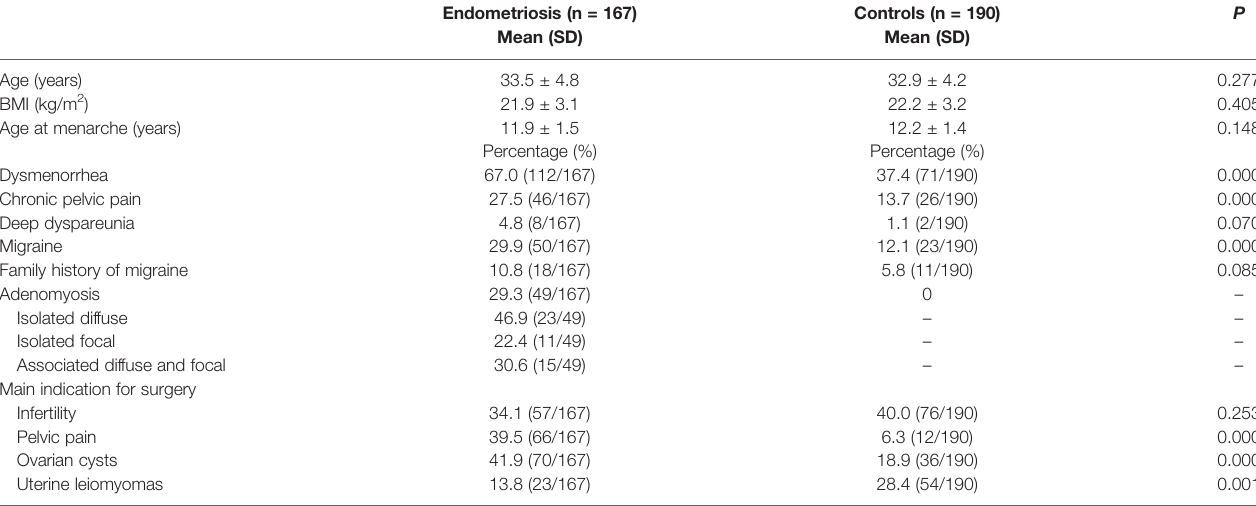
TABLE 1 | Comparison of the general characteristics of controls and cases of